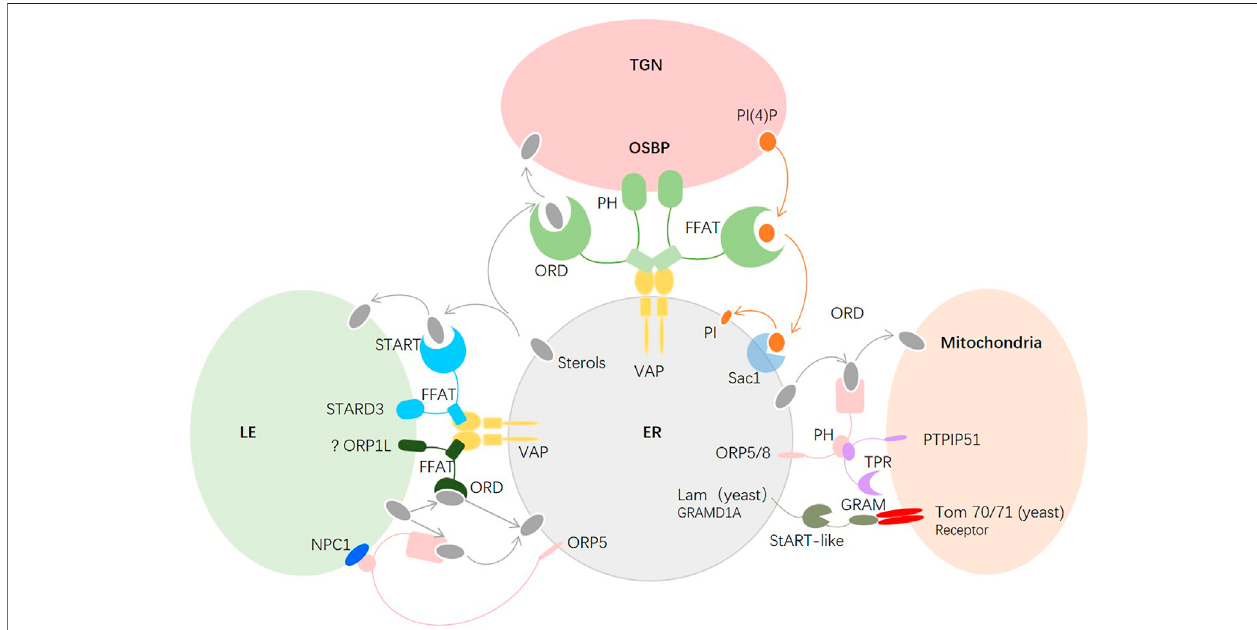
FIGURE 3 | Major molecules in intracellular cholesterol transport. Between the ER and the TGN, OSBP bridges the two membranes, sterols of the ER that bind to theORDaretransferredtotheTGN,andtheORDofOSBPtransfersPI(4)PoftheTGNbacktotheER.BetweentheERandthemitochondria,ORP5/ORP8oftheERand PTPIP51ofthemitochondriatetherthetwoorganellesattheMAM,andtheORDofORP5/8transfersthesterolsoftheERtothemitochondria.Inyeast,Lam6plocatedin the ER facilitates the sterol transfer by interacting with Tom70/71 in the OMM. The conserved mammalian ortholog of Lam6p is GRAMD1A, which is proposed to interact with the receptor of the mitochondria to transfer sterols.